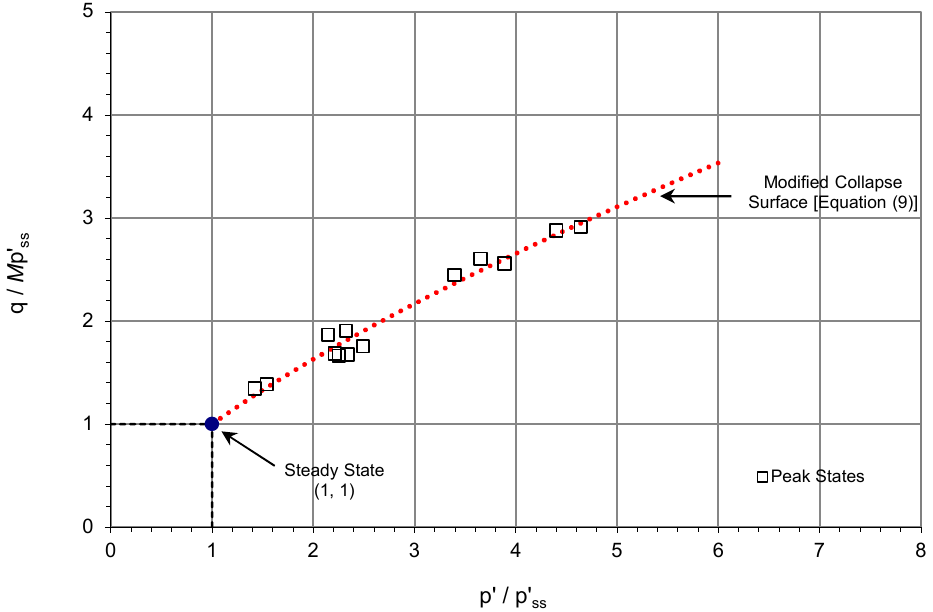
Figure 7. Modified collapse surface from the peak states of ICU results.